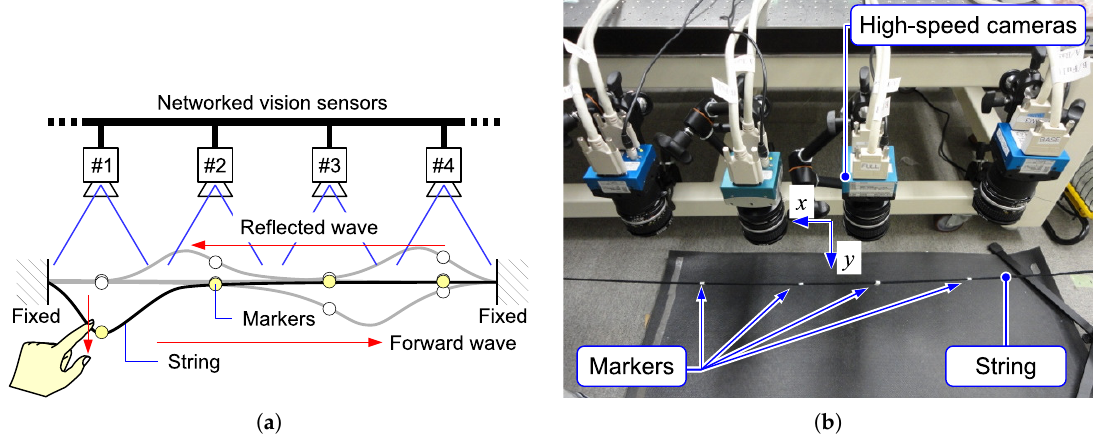
Figure 14. ( a ) Experiment with a vibrating string. ( b ) Experimental